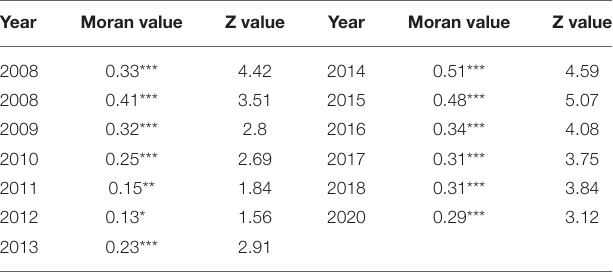
TABLE 3 | Global Moran’s/index 2008 – 2020.